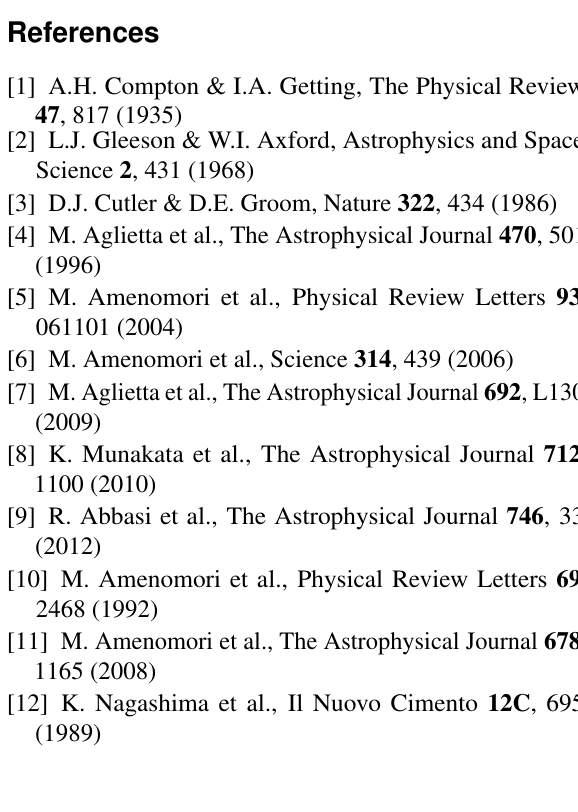
Table 3: Fitting Results of the Amplitudes and Phases of the Multi-TeV Additional Anisotropy with a Flat Line Φ fit ( h ) Energy A fit ( 10 − 3 %) χ 2 / d.o.f. χ 2 / d.o.f. × (TeV) (stat. + sys.)